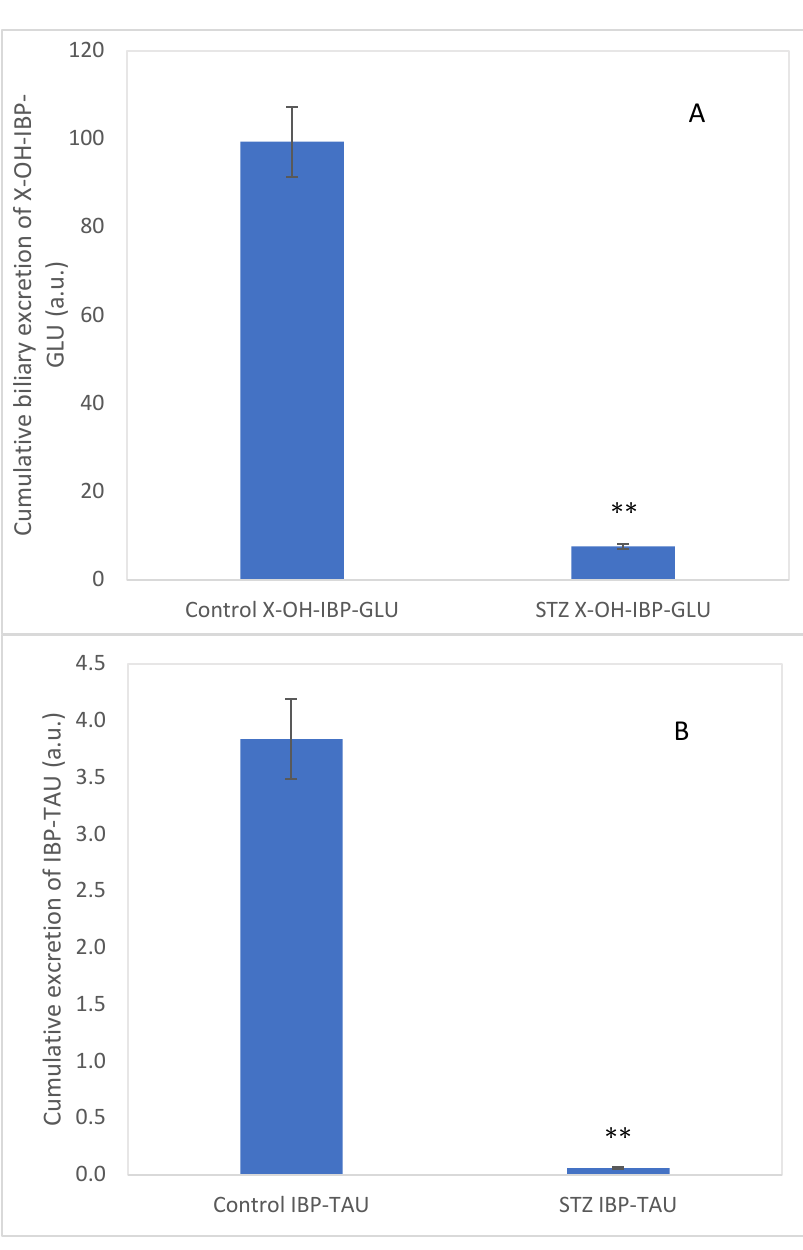
Figure 5 . Cumulative biliary excretion (HPLC-MS based integration) of the ( A ) X-OH-IBP-GLU ( 9 ) and ( B ) IBP-TAU ( 7 ) after the 90-min luminal perfusion of 250 µ M IBP in control and hyperglycemic (STZ) rats. Each value represents the average of five independent experiments ± standard error. Significant difference from the control value: ** p < 0.01.